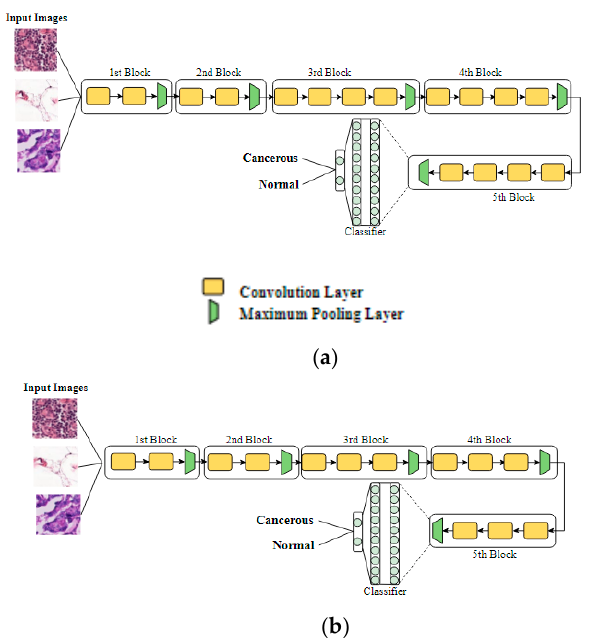
Figure 5. This figure shows VGG network architectures: ( a ) VGG19 architecture and ( b ) VGG16 architecture.